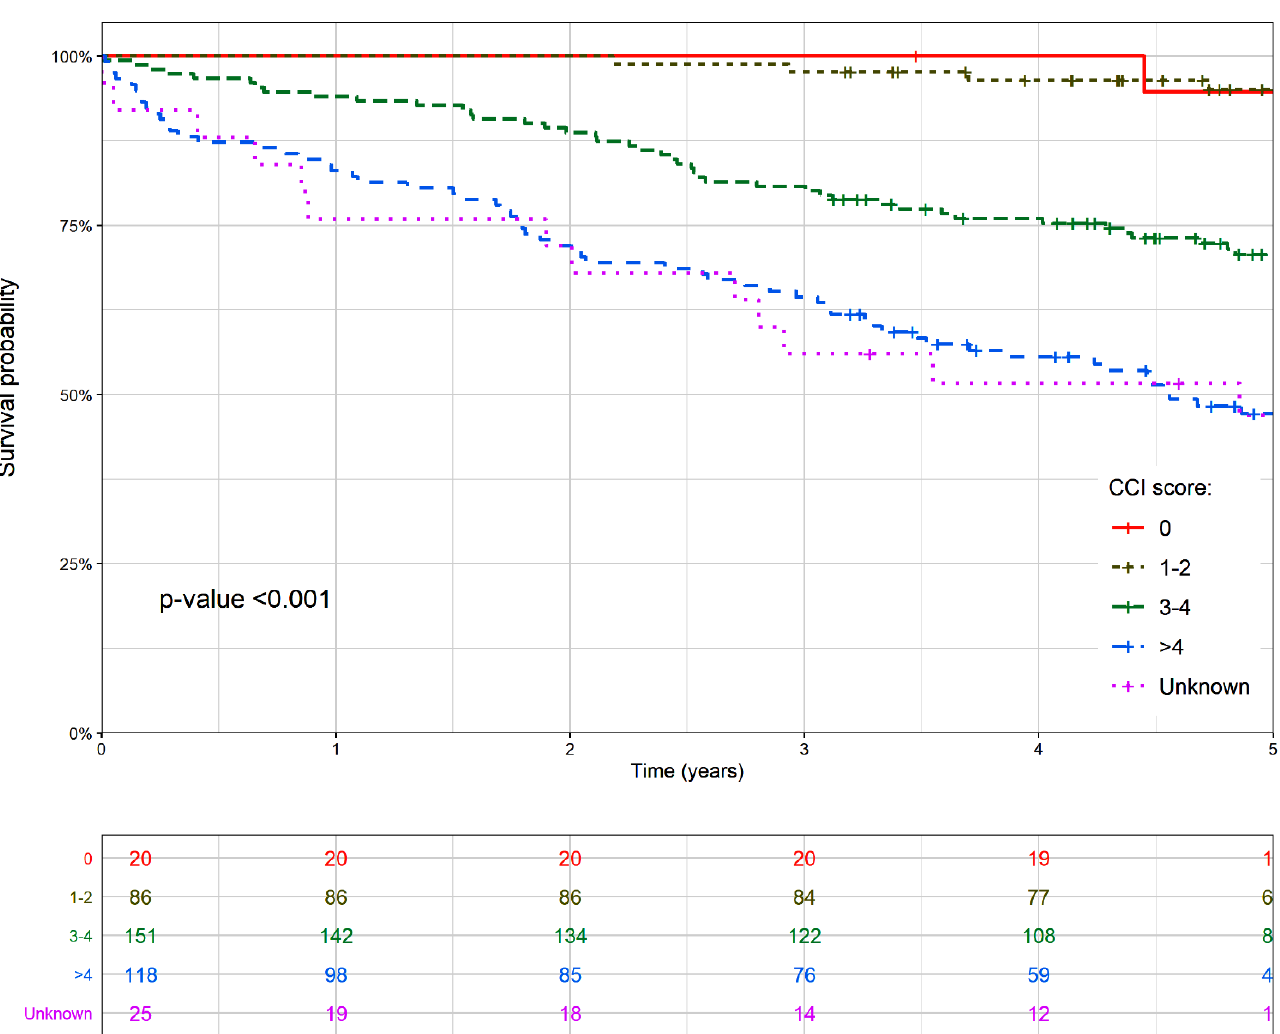
Figure 2. Observed survival of patients with chronic lymphocytic leukemia by the Charlson comorbidity index at diagnosis. Events included both types of death, CLL-related and CLL-unrelated. The differences between the survival curves that had a p -value <0.05 were considered to be statistically significant.